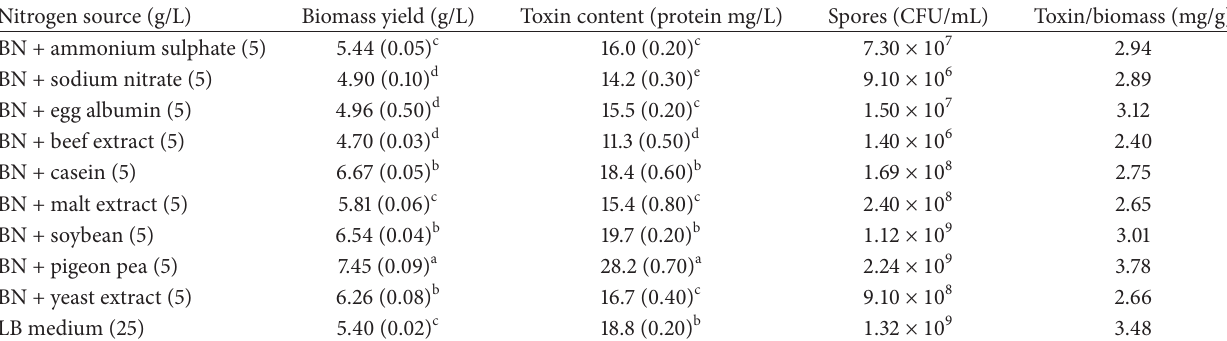
Table 2: Comparative analysis of Bt 𝑠𝑣2 production in different nitrogen